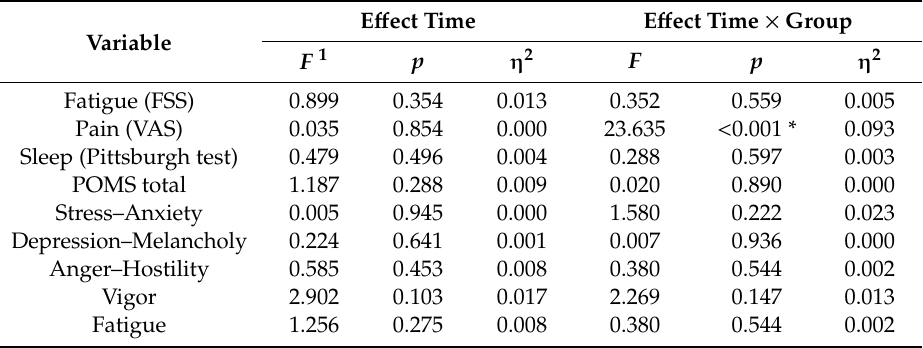
(Figure 2) after the intervention (MD: 2.9, p = 0.044, ES: 0.593) in favour of the manual therapy group. However, no significant e ff ects were found in any other variable. Table 2. E ff ect of manual therapy